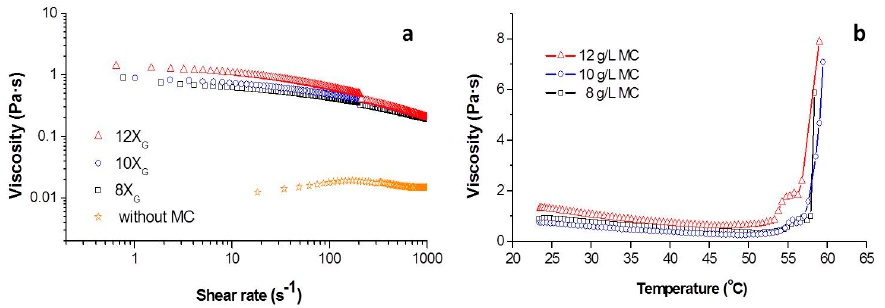
Figure 2. ( a ) Flow curves of Ti slurries with 50 vol. % of solid contents formulated without MC and with 8, 10 and 12 g/L of MC. ( b ) Viscosity values vs. Temperature for 50 vol.% slurries with 8, 10 and 12 g/L of MC.